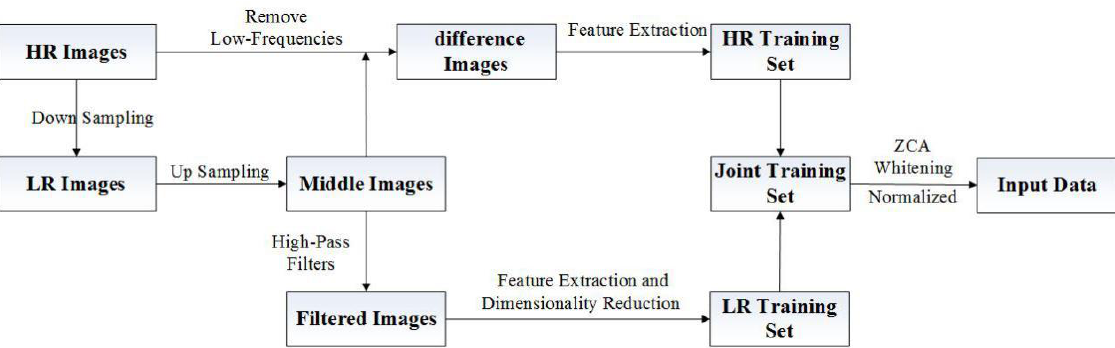
Figure 1. Framework of the proposed training set preprocessing method. HR: high resolution; LR: low resolution; ZCA: zero-phase component analysis.